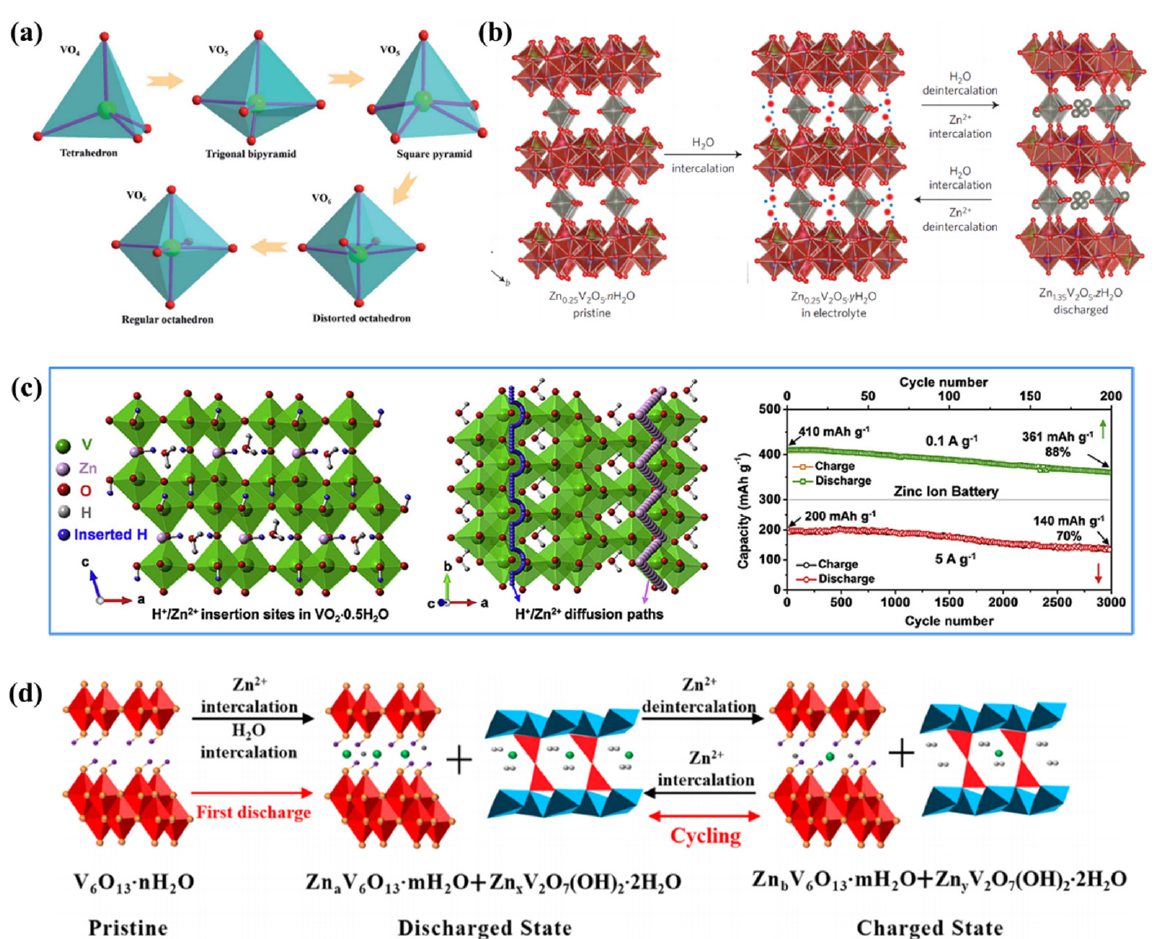
Figure 2. ( a ) Classification of V − O coordination polyhedron (Ref. [20]). ( b ) Structural changes of Zn 0.25 V 2 O 5 ·nH 2 O during electrochemical reaction (Ref. [32]). ( c ) The insertion site ( left ) and migration pathway ( middle ) of Zn 2+ and H + during charging and the long cycle performance ( right ) of VO 2 · 0.45H 2 O (Ref. [33]). ( d ) A schematic diagram of reversible extraction/insertion of Zn 2+ and water molecules in V 6 O 13 · nH 2 O during initial charge/discharge and subsequent processes (Ref. [34]).